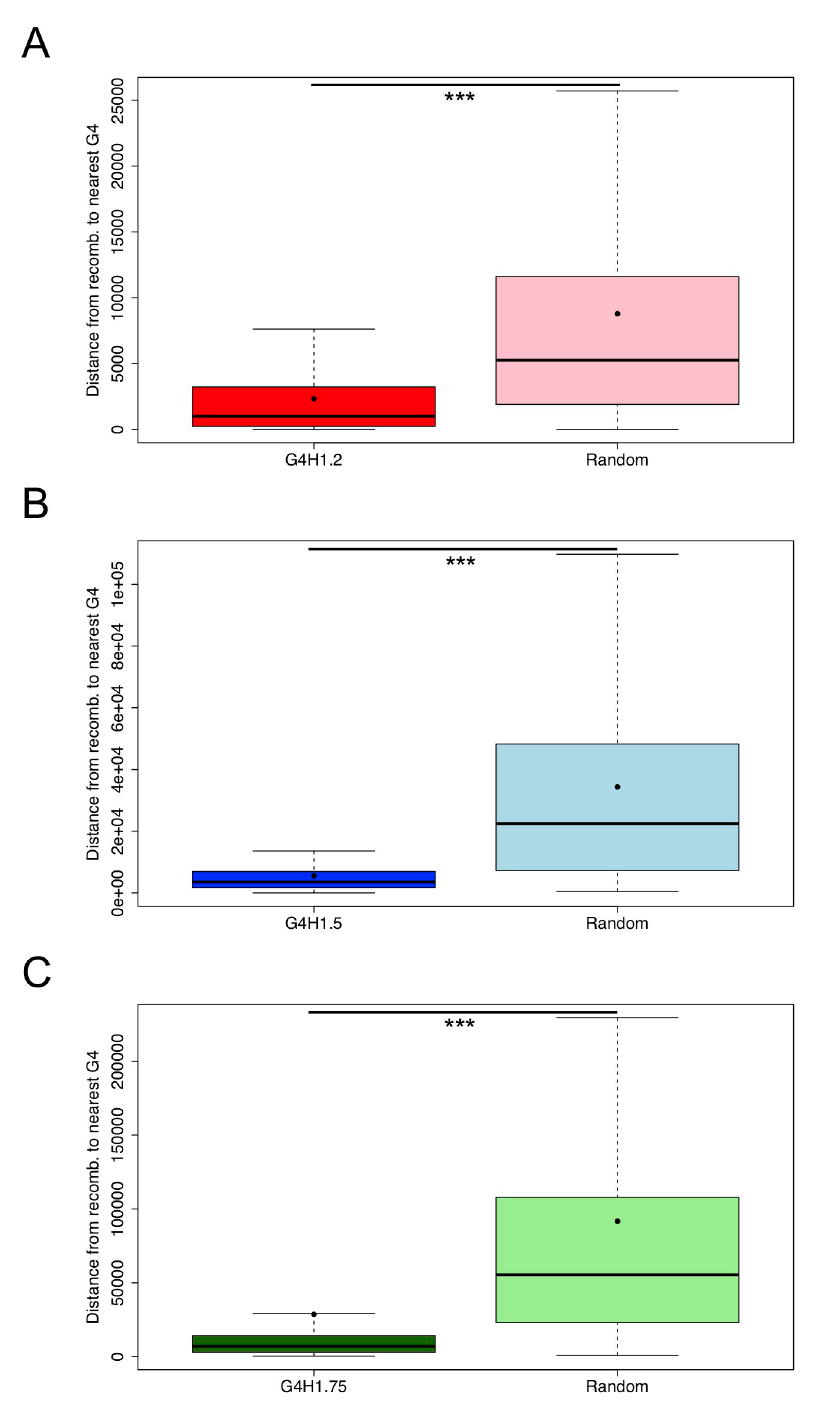
Fig 5. G4FS are associated to recombination events. (A-C) Boxplots showing the distance from recombination breakpoints to the nearest G4FS for the three applied thresholds: G4H1.2 (A), G4H1.5 (B) and G4H1.75 (C). For comparison, a null dataset with 10 randomizations of recombination sites was generated and one random condition is shown for each threshold. The mean distance to recombination breakpoints of each G4H list (black point) was found significantly different from null dataset (Wilcoxon test, ��� p -value <